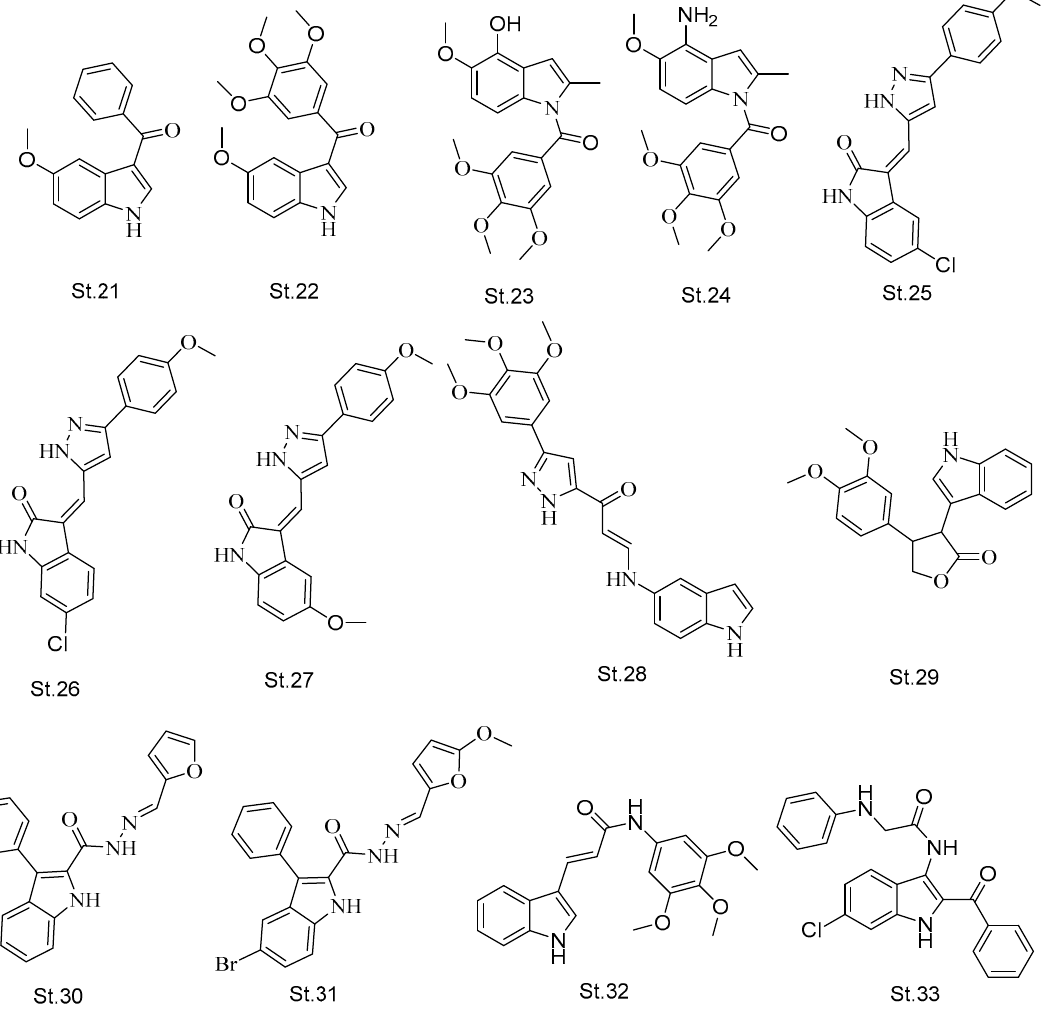
Figure 7. The structures of aroylindoles, trimethoxyphenyl-indole, indolyl-phenylmethanone, pyrazole-oxyindole, indole-amino-pyrazolyl, and indole-heterocyclic hybrid. Many kinds of research have been focused to discover hybrid chemical agents with